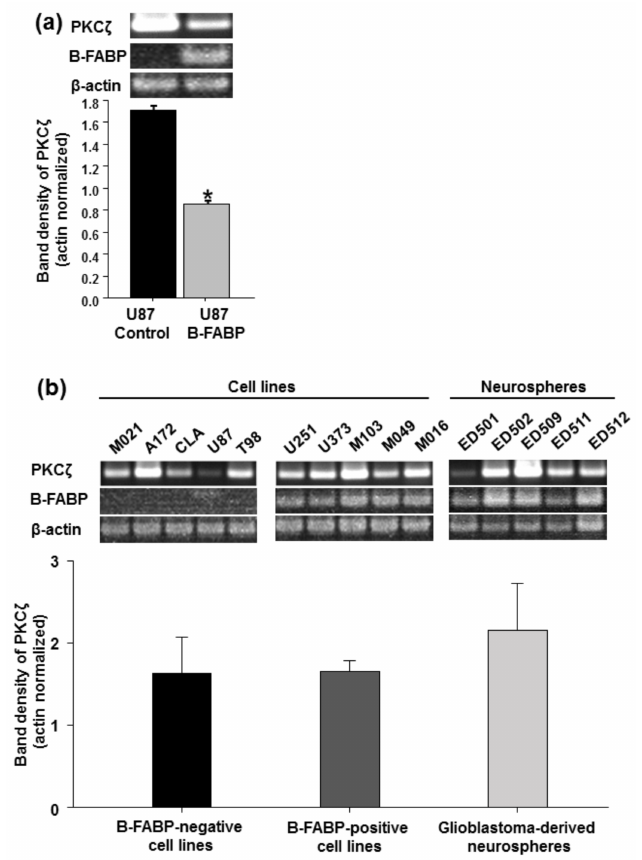
Figure 1. B-FABP and PKC ζ expression in glioblastoma multiforme (GBM) cell lines and neurospheres: ( a ) PKC ζ and B-FABP expression in U87 GBM cells stably transfected with either empty pREP4 vector (U87 Control) or a pREP4-FABP7 expression construct (U87 B-FABP), n = 3 independent replicates and * indicates significant difference compared with U87 Control cells; ( b ) PKC ζ and B-FABP expression in GBM cell lines that are negative for B-FABP (M021, A172, CLA, U87, and T98), GBM cell lines that are positive for B-FABP (U251, U373, M103, M049, and M016), and GBM tumor neurosphere cultures generated from five different GBM patients (ED501, ED502, ED509, ED511, and ED512). Band